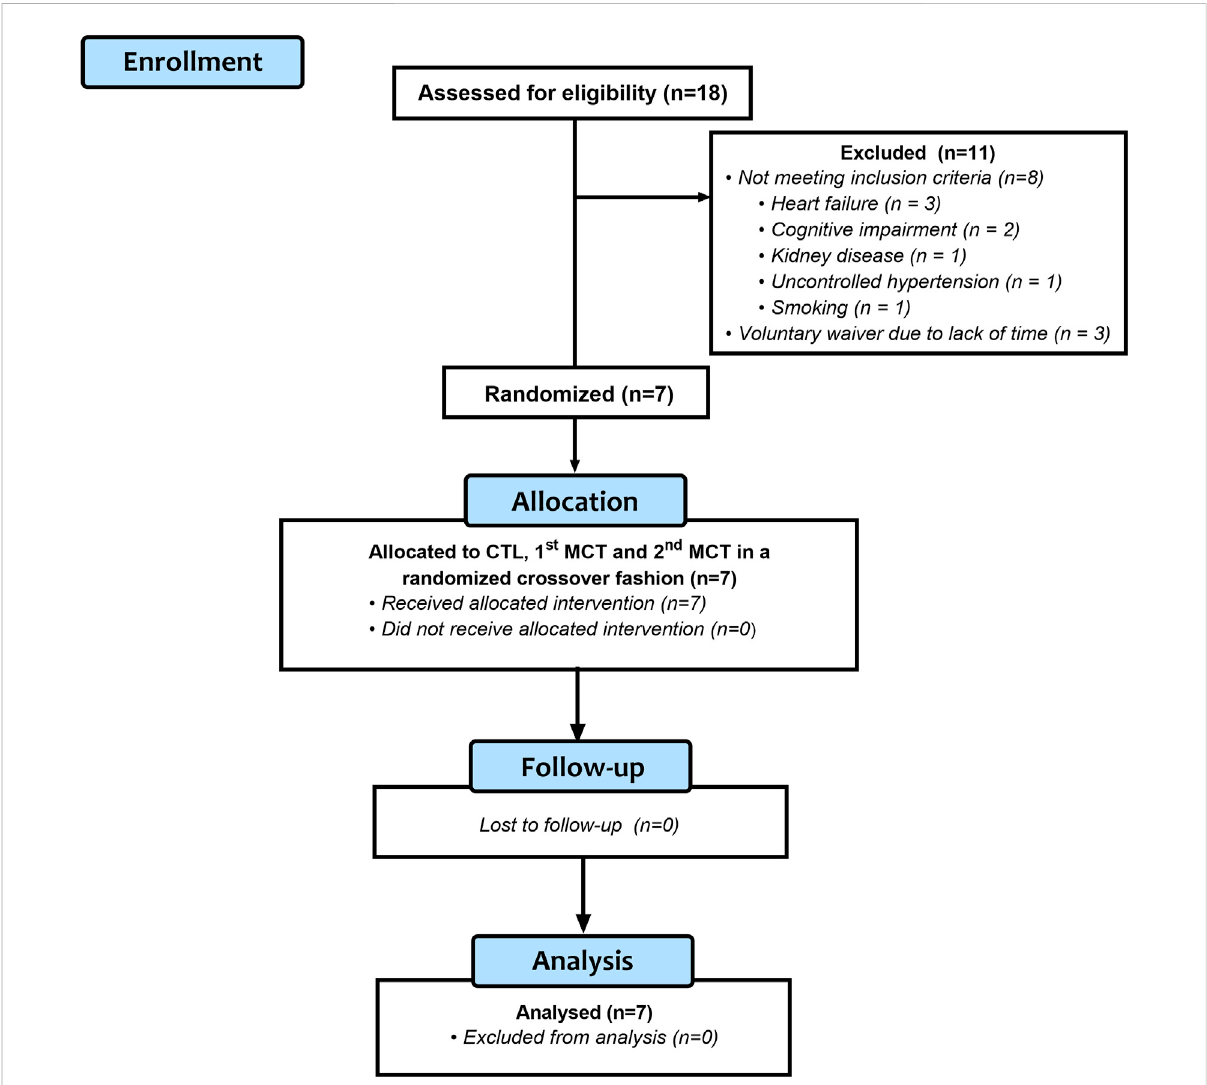
FIGURE 1 Flowchart for the study. MCT, mixed circuit training; CTL, non-exercise control session.